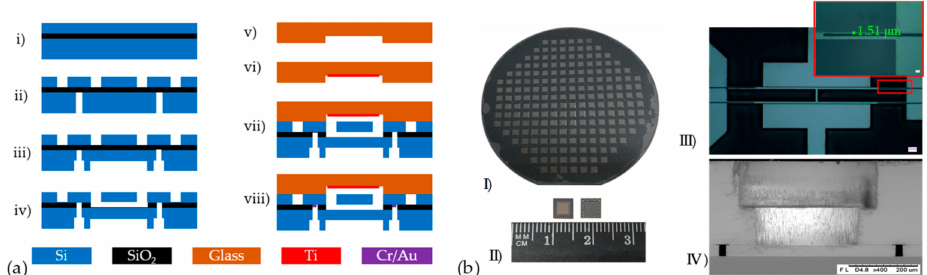
Figure 4. ( a ) The fabrication processes: ( i ) cleaning of the SOI wafer; ( ii ) form the resonators and smaller sleeve holes; ( iii ) form the pressure sensitive diaphragm and the bigger sleeve holes; ( iv ) rRemoving the SiO 2 beneath the resonators and in sleeve holes; ( v ) rooming the cavity in glass; vi ) sputtering Ti as getter; ( vii ) anodic bonding and ( viii ) Cr / Au metallization. ( b ) The fabrication results: ( I ) wafer after anodic bonding; ( II ) the front / back views of the sensor chips after dicing; ( III ) picture of resonator; and ( IV ) SEM picture of the sleeve